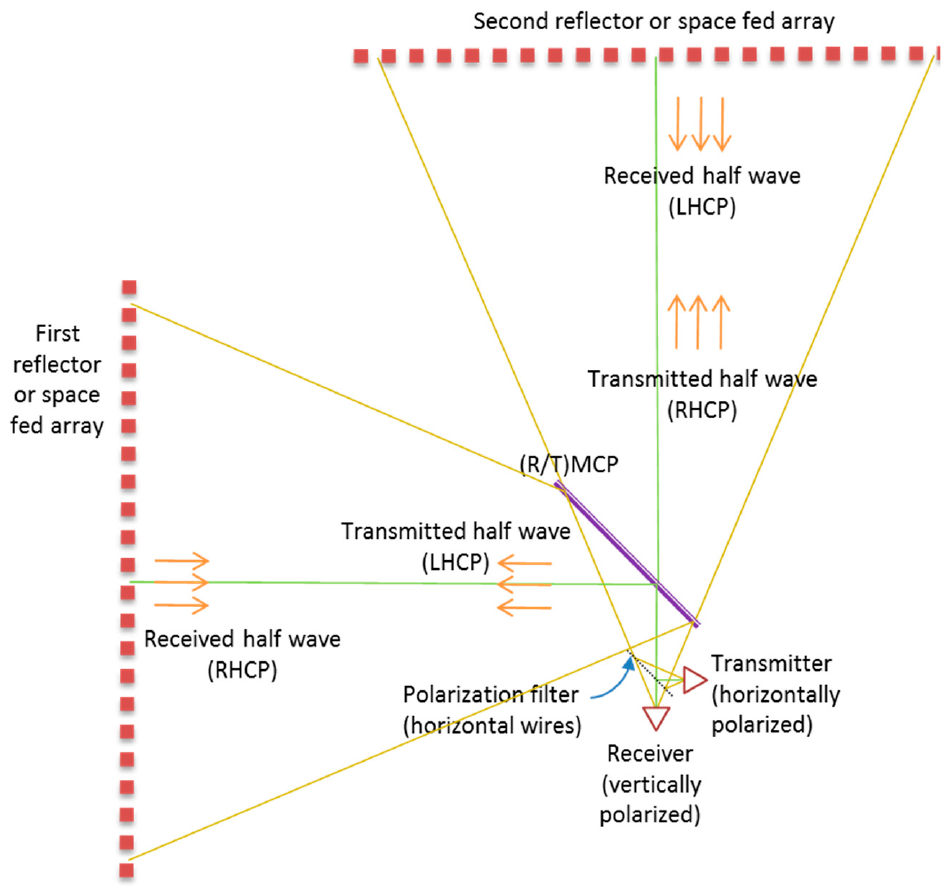
Figure 7. Schematic of the potential application of surfaces that reflect half of the linearly polarized wave and transmit the other half with circular polarization (CP) for two array systems with a single feed antenna.